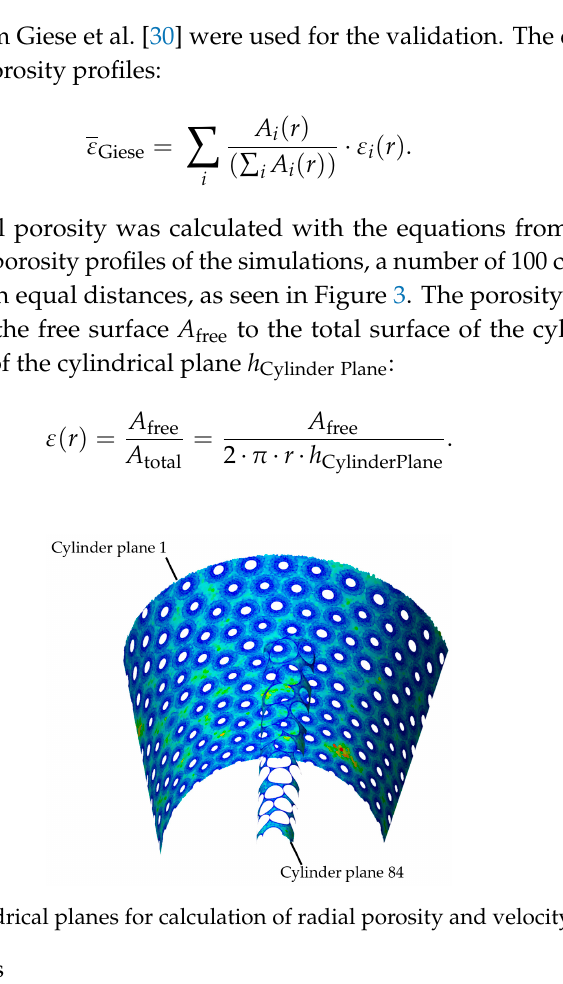
Table 3. Comparison of DEM and rigid body settings.